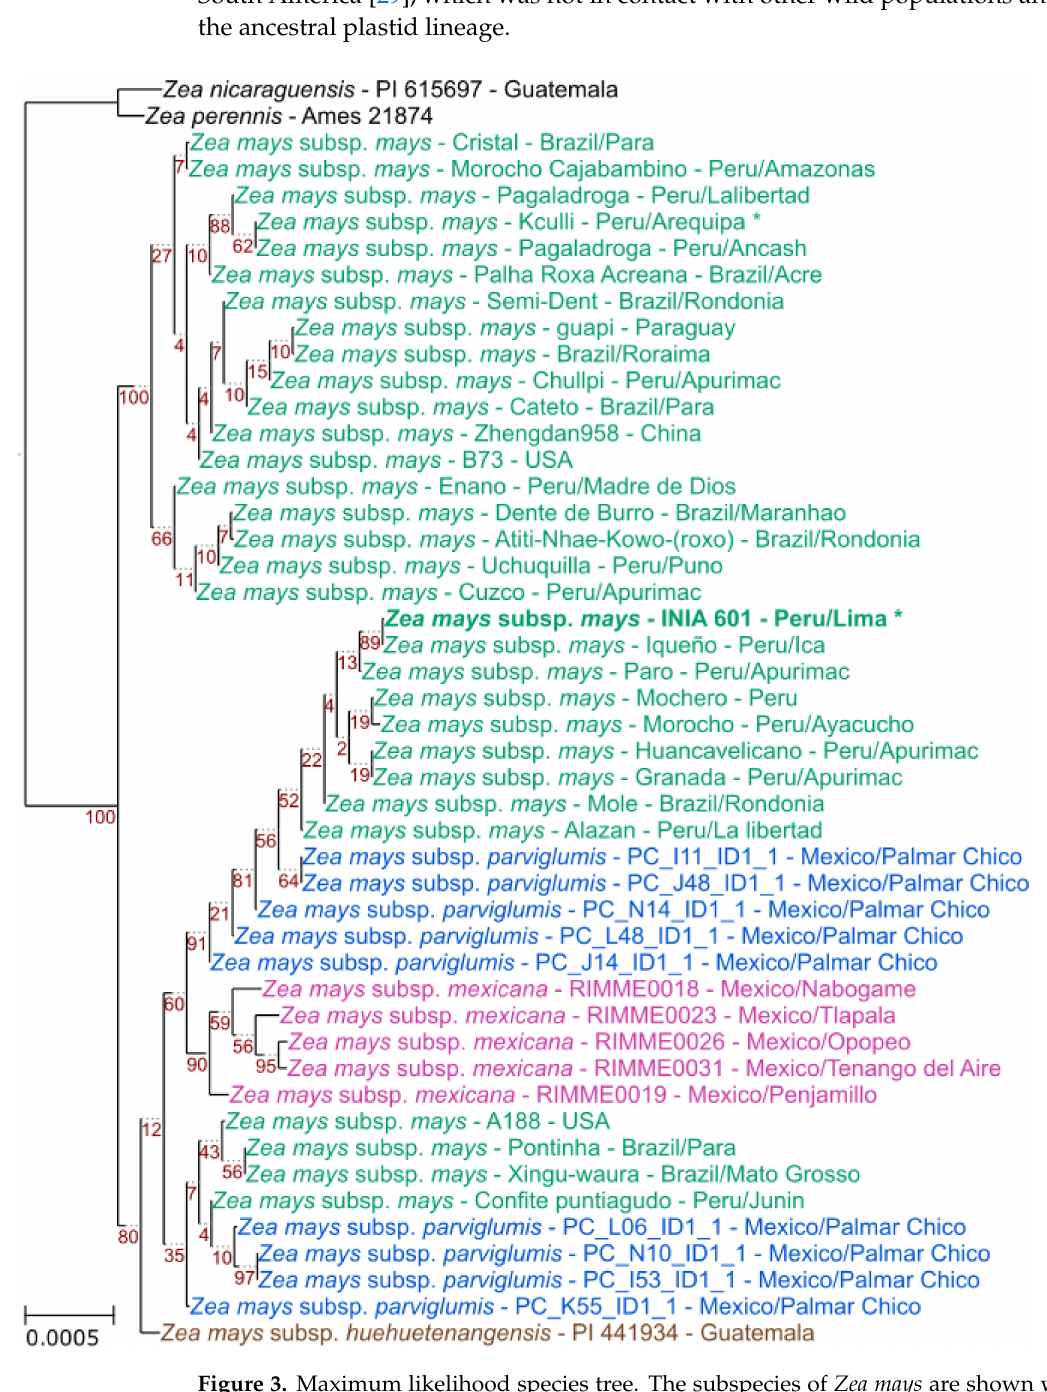
Figure 3. Maximum likelihood species tree. The subspecies of Zea mays are shown with different colors: green— Z . mays subsp. mays , blue— Z . mays subsp. parviglumis , pink— Z . mays subsp. mexicana , brown— Z . mays subsp. huehuetenangensis . All bootstrap values are shown in red. The asterisk (*) indicates purple